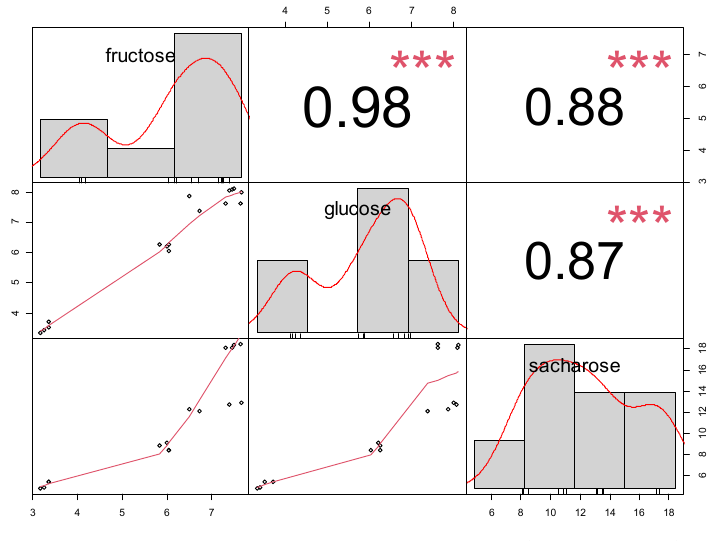
Figure 4. Correlation matrix of sugar yields (mg kg − 1 × yield t ha − 1 ). Note: *** ( p <